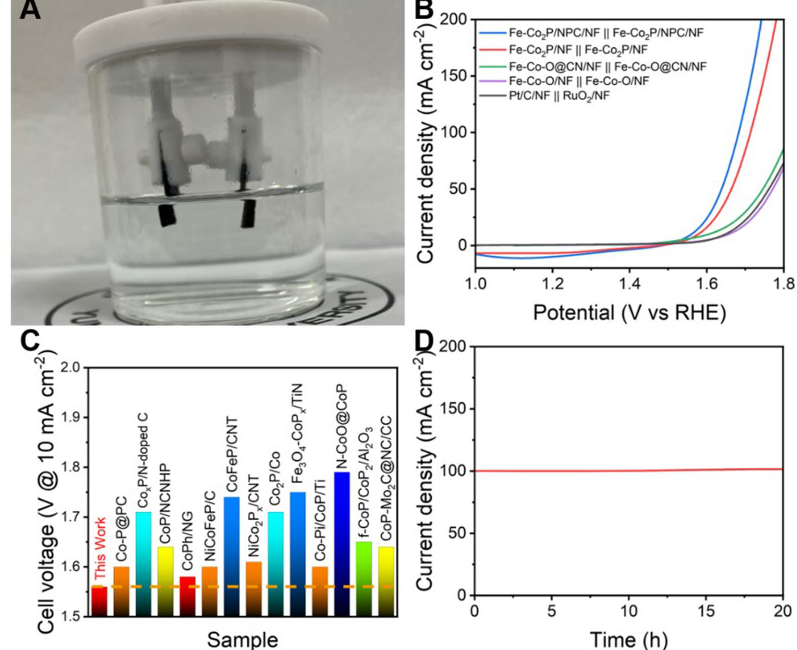
Figure 5. Performance of Fe-Co 2 P/NPC/NF in water-splitting reaction. ( A ) Photograph of a Fe- Co 2 P/NPC/NF electrolyzer unit. ( B ) Polarization curves in 1 M KOH with 90% iR correction. ( C ) Cell voltage of different catalysts. ( D ) Chronopotentiometry curve of Fe-Co 2